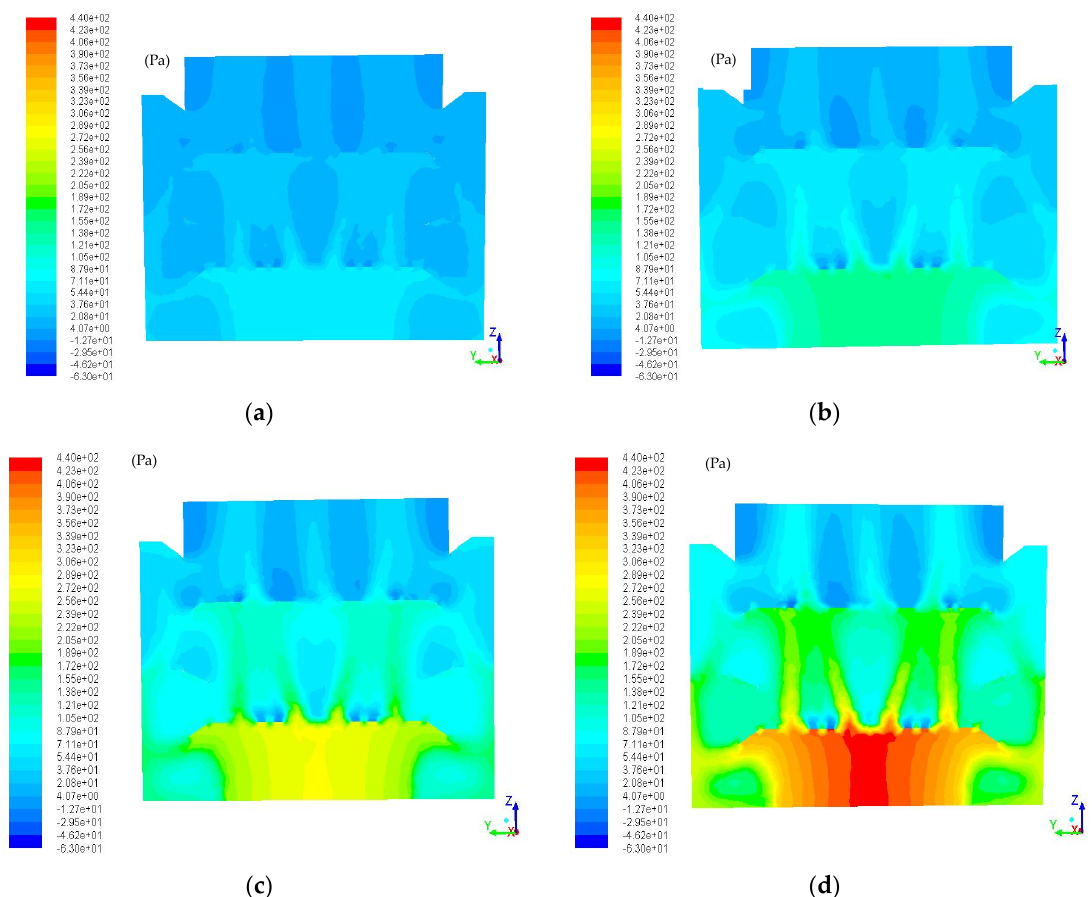
Figure 5. CFD-simulated pressure distribution changes in non-powered hydraulic mixing with different inlet velocities. ( a ) Inlet velocity: 0.2 m/s; ( b ) inlet velocity: 0.3 m/s; ( c ) inlet velocity: 0.4 m/s; ( d ) inlet velocity: 0.5 m/s